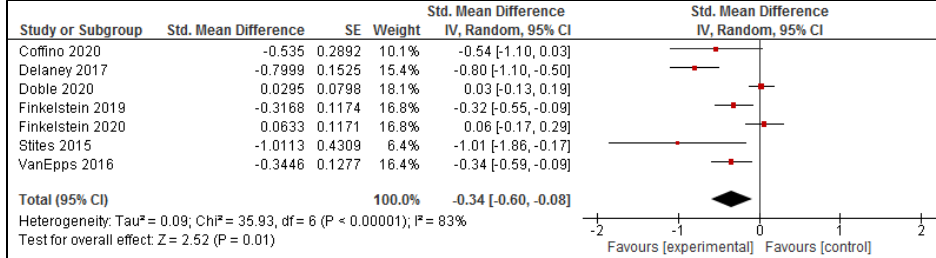
Figure 3. Effect of intervention delivered via online food ordering systems on the Energy content of purchases.